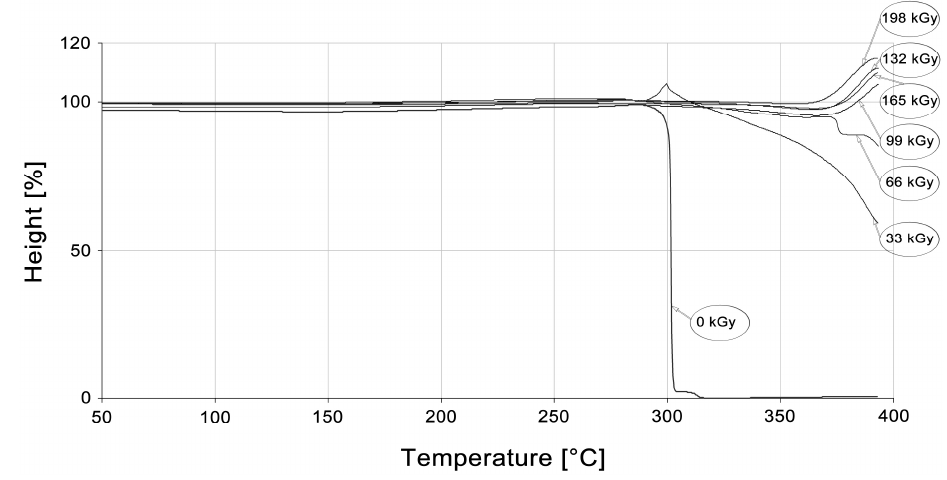
Figure 22. TMA—High-performance polymers (PA9T).